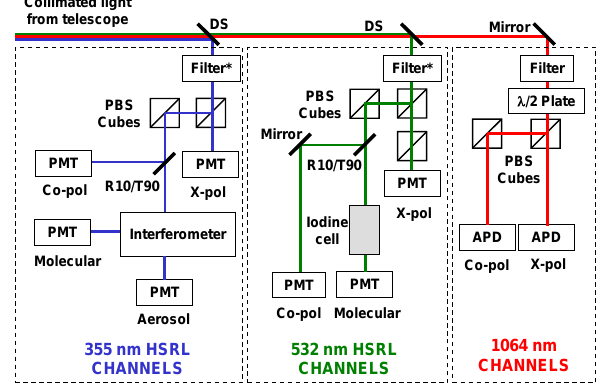
Figure 2. A simplified block diagram of the receiver optics relevant for linear depolarization measurements by HSRL-2. The abbrevia- tions are as follows: PMT is photomultiplier tube; APD is silicon avalanche photodetector; DS is dichroic beam splitter; PBS is po- larizing beam splitter; co-pol is co-polarized channel (with respect to the transmitted light); X-pol is cross-polarized channel. The col- limated light arrives from the telescope and is split into the three wavelengths using dichroic beam splitters. The first optical com- ponent filters solar background using either an interference filter (indicated “Filter”) or an interference filter and etalon in combi- nation (indicated “Filter ∗ ”). The 1064nm channel also includes an additional half-wave plate, which can be used to correct any small polarization misalignment in the receiver system since the 532 and 1064nm beams are transmitted together. This half-wave plate is set during installation and is not rotated during normal operations. The light then passes through polarization beam splitters to be separated into components co-polarized and cross-polarized with respect to the transmitted beam. Since the transmittance ratio of the light exit- ing a PBS is greater in the transmitted direction than in the reflected direction, a second cleanup PBS is included for each detector wave- length to further improve the transmittance ratio for the co-polarized light. (An extra clean up PBS is also included for the cross-polarized light in the 532nm channel.) The co-polarized signal and cross- polarized signal are used to determine volume depolarization ra- tio at each wavelength. The 355 and 532nm co-polarized channels are split again and passed through additional optics to separate the aerosol and molecular signals (see